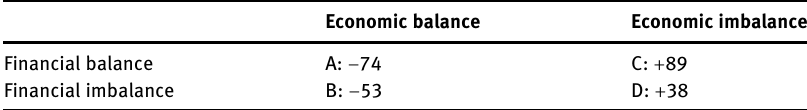
Table  : Matrix of fi nancial and economic health, changes from  to 